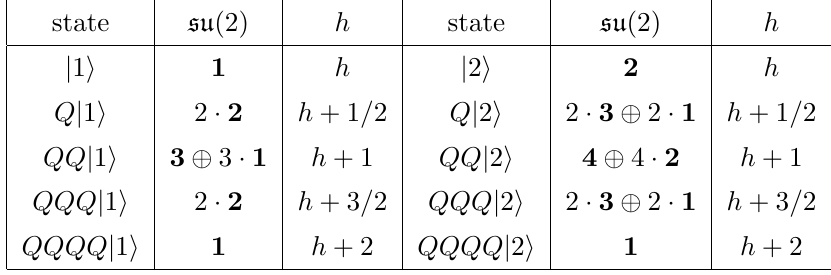
Table 7 . Chiral long N = 4 multiplet for m = 1 and m =